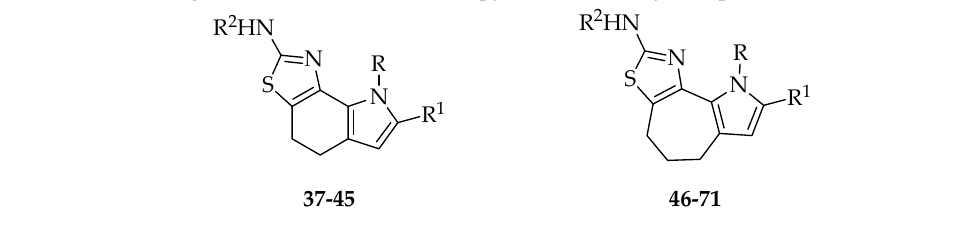
Table 2. [1,3]Thiazolo[5,4 ‐ g ]indole ‐ 2 ‐ amines 37 – 45 and pyrrolo[3’,2’:6,7]cyclohepta[1,2 ‐ d ][1,3]thiazol ‐ 2 ‐ amines 46 – 71.